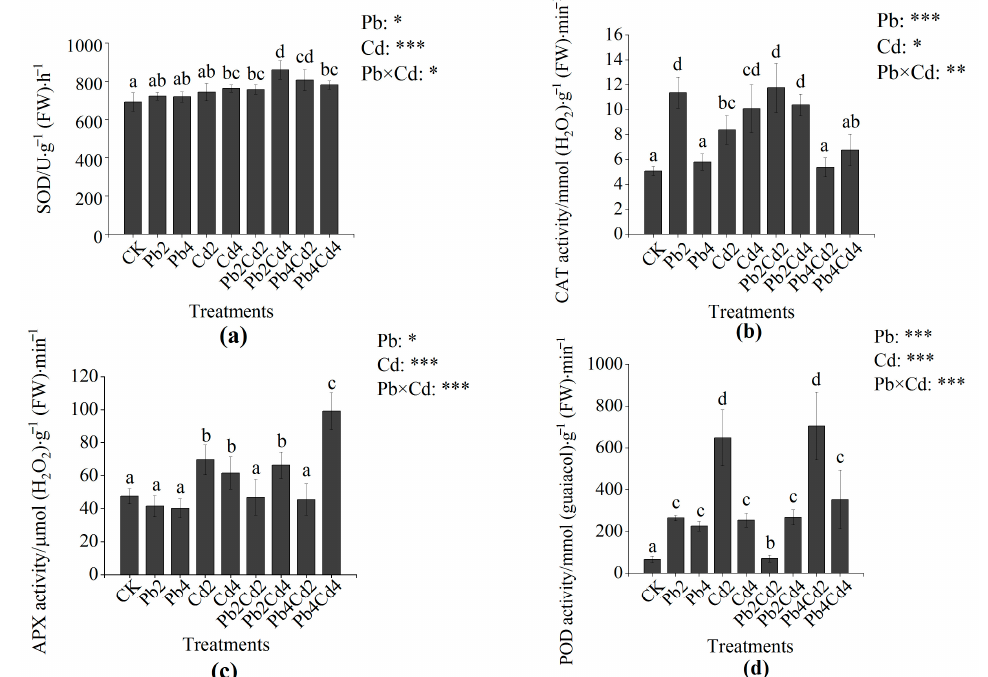
Figure 2. Effects of individual and combined Pb and Cd stress on the antioxidant enzyme activities in F . parvifolia . ( a ) The superoxide dismutase (SOD). ( b ) The catalase (CAT). ( c ) The ascorbate peroxidase (APX). ( d ) The peroxidase (POD). The post hoc test used for the estimation of the significance level is the Duncan test. Different lowercase letters indicate significant differences at p < 0.05 between treatments. Each value represents mean values ± SEs (n = 5). *, p < 0.05; **, p < 0.01; ***, p < 0.001.